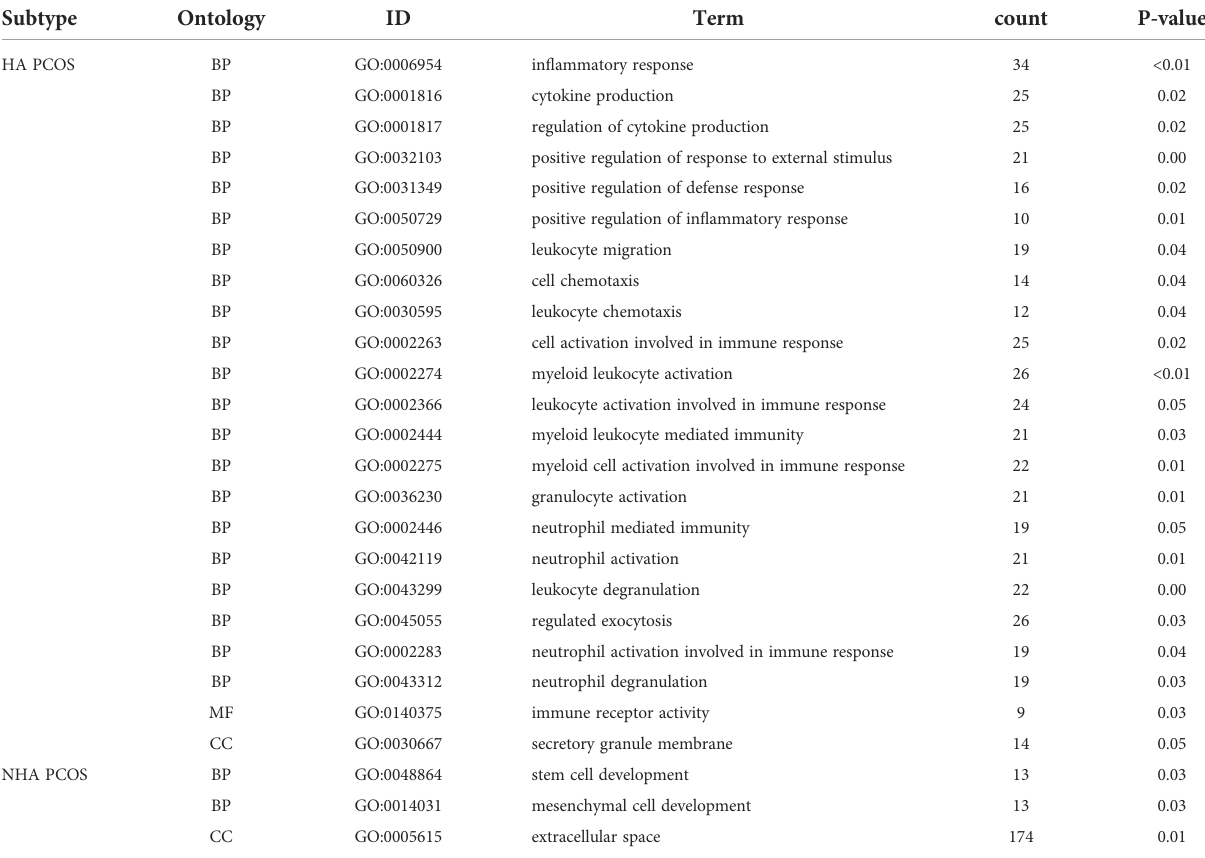
TABLE 2 GO enrichment analysis for HA PCOS and NHA PCOS.